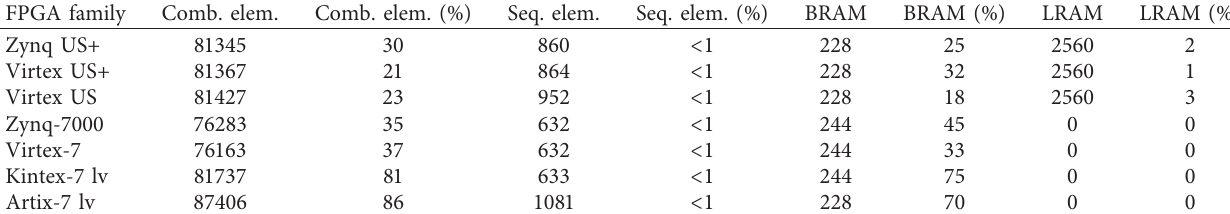
Table 5: Hardware accelerator implementation on Xilinx FPGAs.